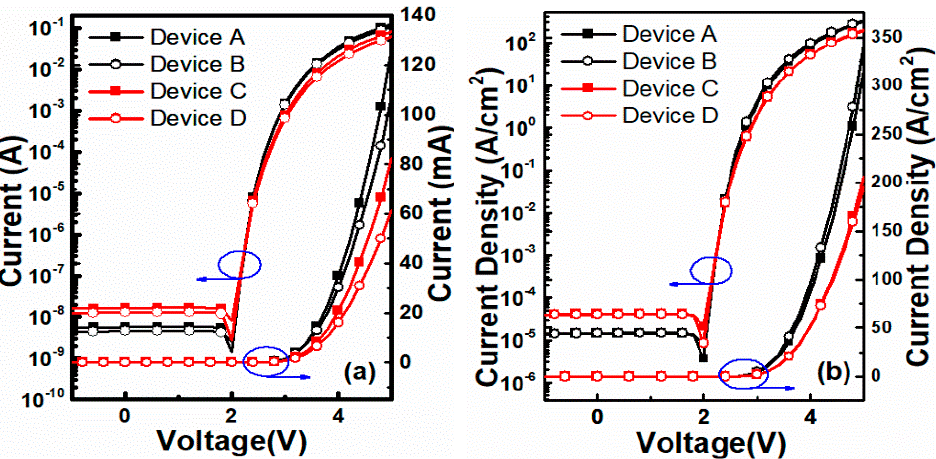
Figure 3. ( a ) I-V and ( b ) J-V characteristics of micro-LEDs of 4 types of structures.